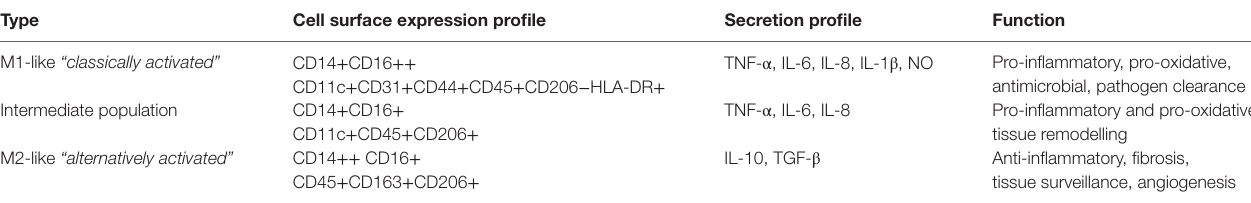
TABLe 2 | Adipose tissue macrophage phenotypic classifications in